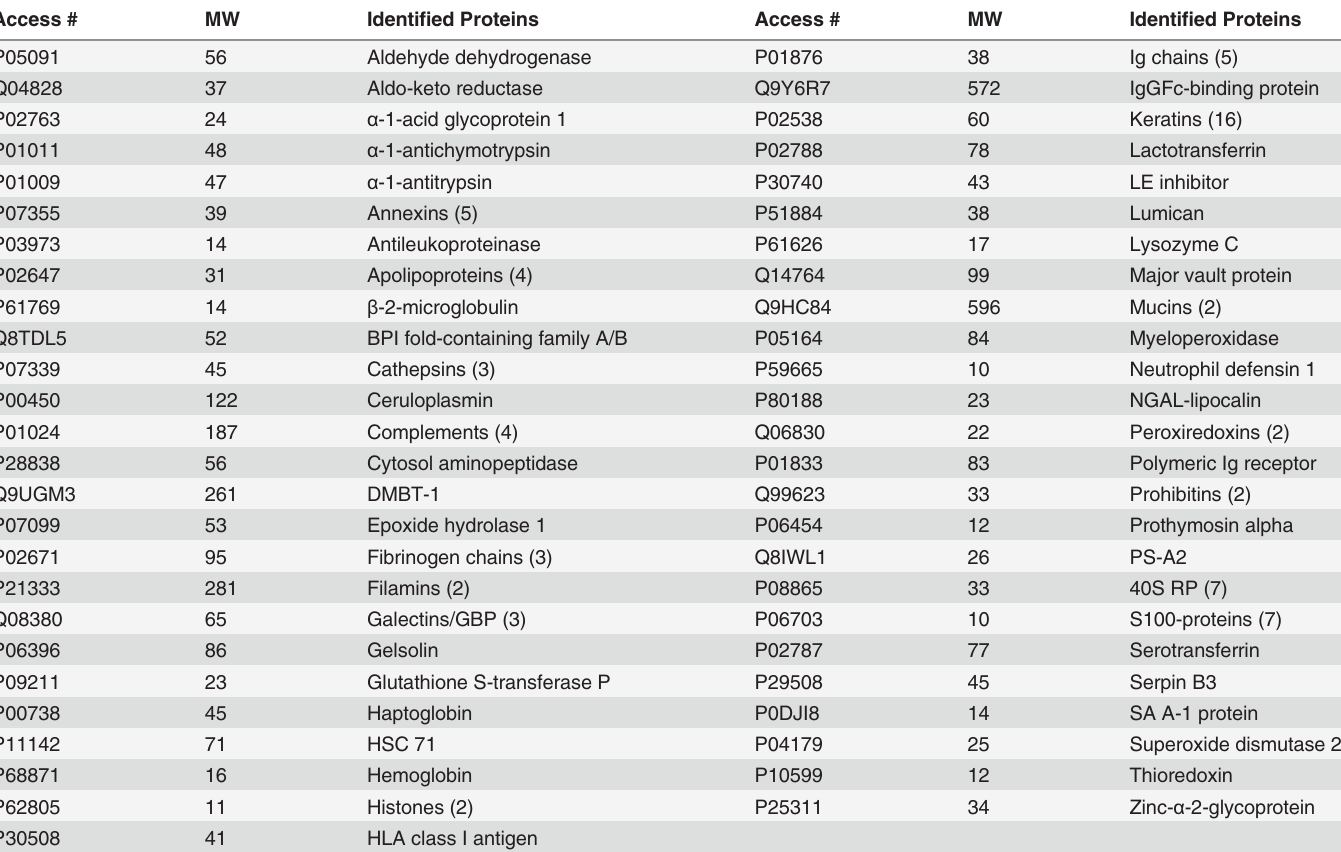
Table 1. Protein families with protective functions found in gland